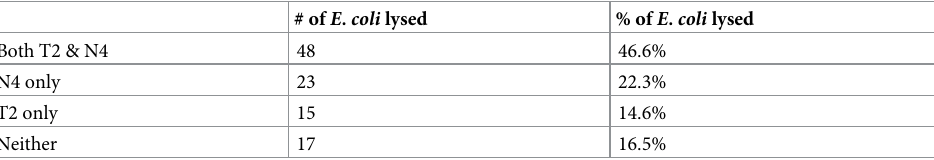
Table 4. Susceptibility of E . coli strains from females with UTI symptoms to bacteriophages T2 and N4. # of E . coli lysed % of E . coli